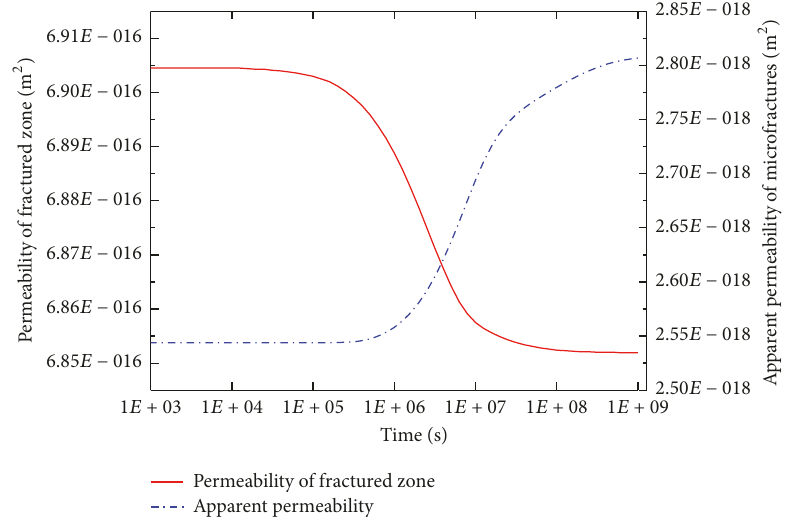
Figure 15: Evolution of permeabilities in fractured zone and microfractures of matrix.